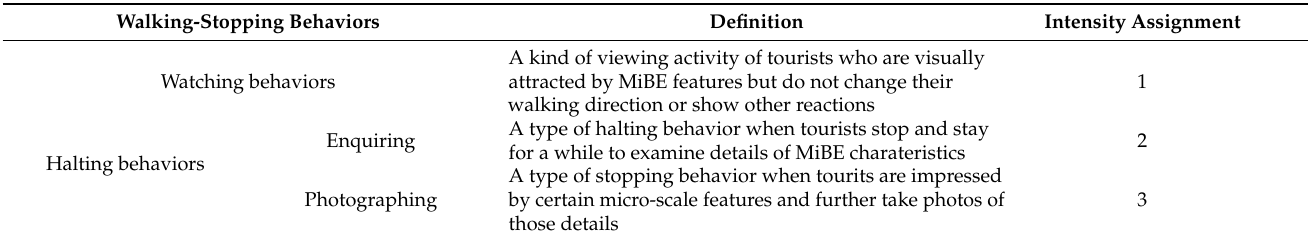
Figure 3. Three types of walking-stopping behaviors captured in Wudaoying Hutong. Table 3. Tourists’ walking-stopping behaviors and their assigned intensity in our